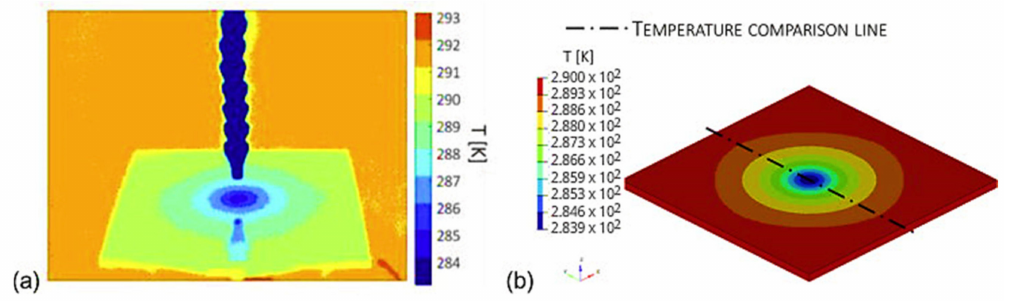
Figure 44. Transient Temperature: ( a ) IR image; ( b ) FE temperature profile. Reprinted with permission from Ref. [85]. Copyright 2018